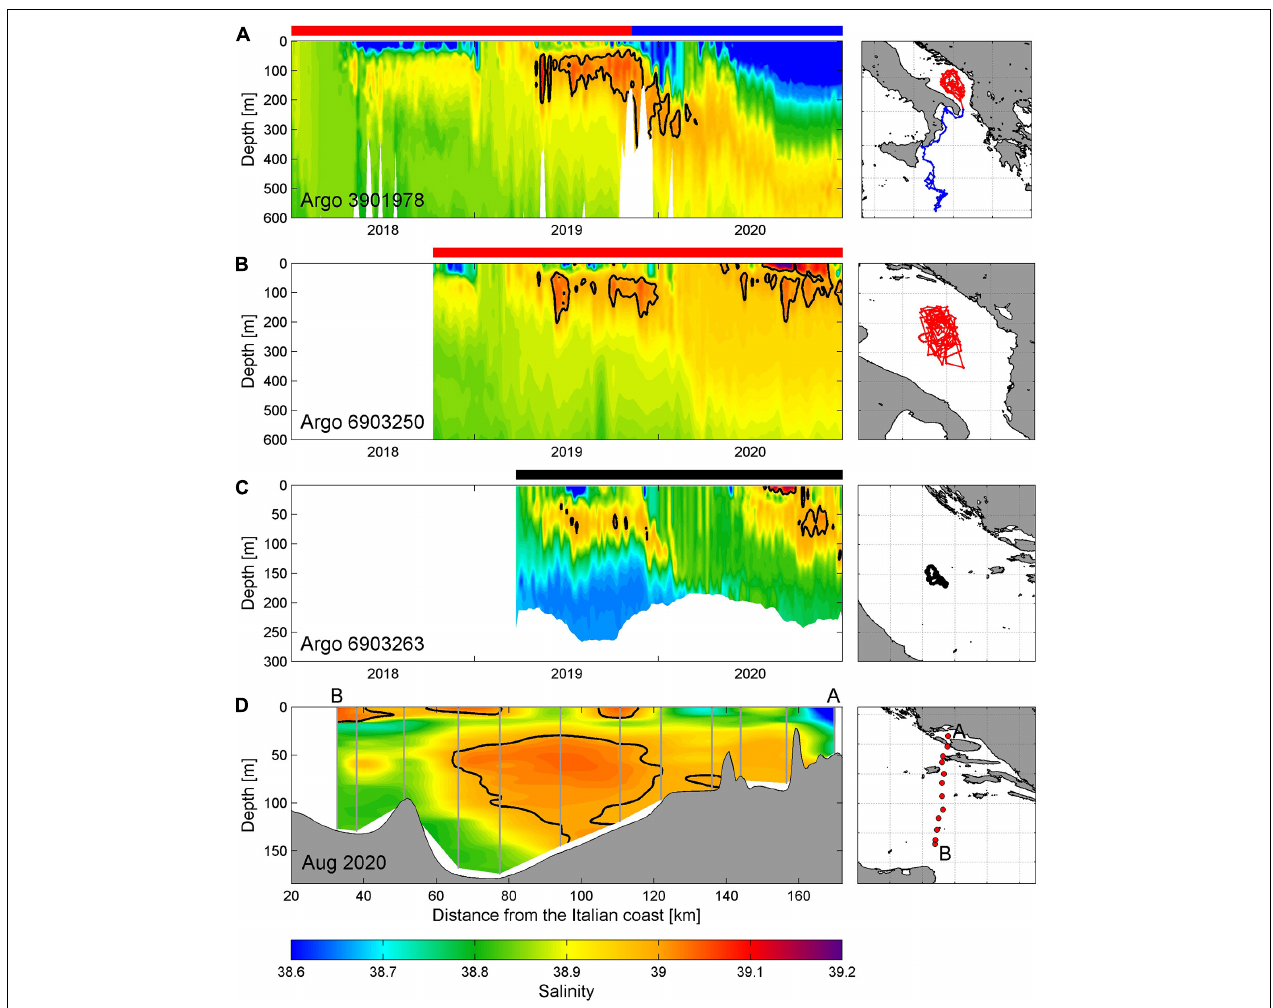
FIGURE 12 | (A) Hovmöller diagram of salinity data for Argo float 3901978 in the first 600 m in the period 2018–2020 (left panel) with corresponding float trajectory (right panel). (B,C) As in panel (A) except for Argo floats 6903250 in the first 600 m (2018–2020) and 6903263 between the surface and the bottom (2019–2020), respectively. Note that the vertical scale in panel (C) is between 0 and 300 m. (D) Salinity profile at the Palagruža Sill transect in mid-August 2020, with the map of CTD stations. Argo trajectories are colored depending on the location of the float (black–Middle Adriatic, red–Southern Adriatic, and blue–Northern Ionian). The same color notation is used in horizontal bars above left panels, indicating periods during which Argos were profiling in respective areas. Thick black line in left panels denotes 39.0 salinity contour. Vertical gray lines in panel (D) denote CTD